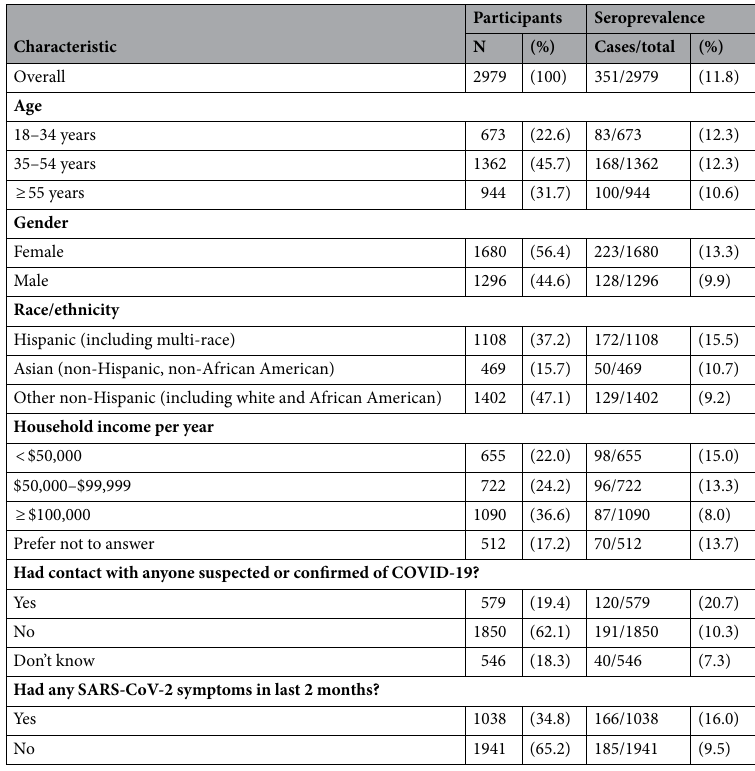
Table 1. Unadjusted SARS-CoV-2 seroprevalence by social, demographic and survey characteristics among 2979 adults in Orange County, CA, July 10th to August 16th, 2020.